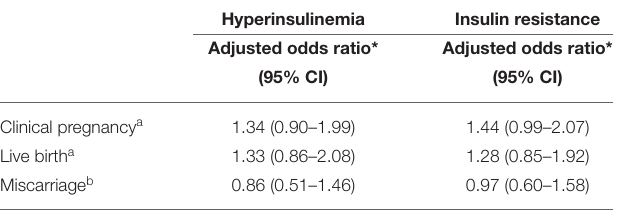
TABLE 5 | Reproductive outcomes in women with hyperinsulinemia and insulin